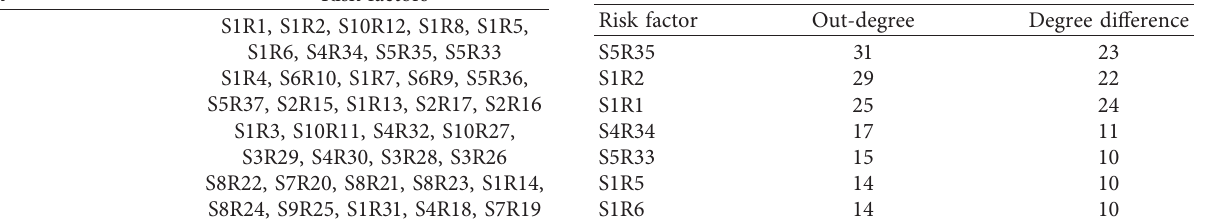
Table 6: Risk factors with a high out-degree and high degree